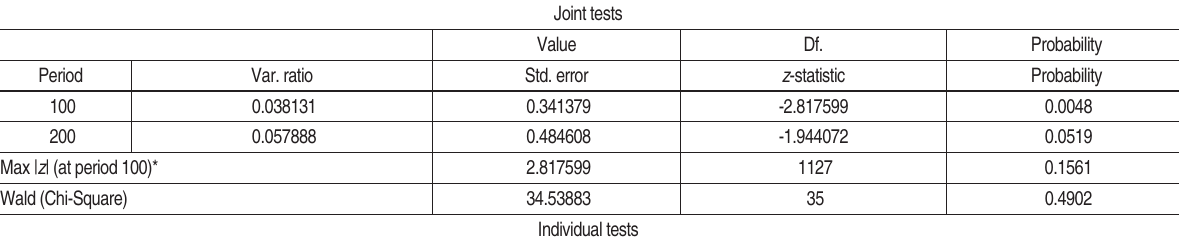
Table 3. Variance ratio test of the NSE 20 share index (daily